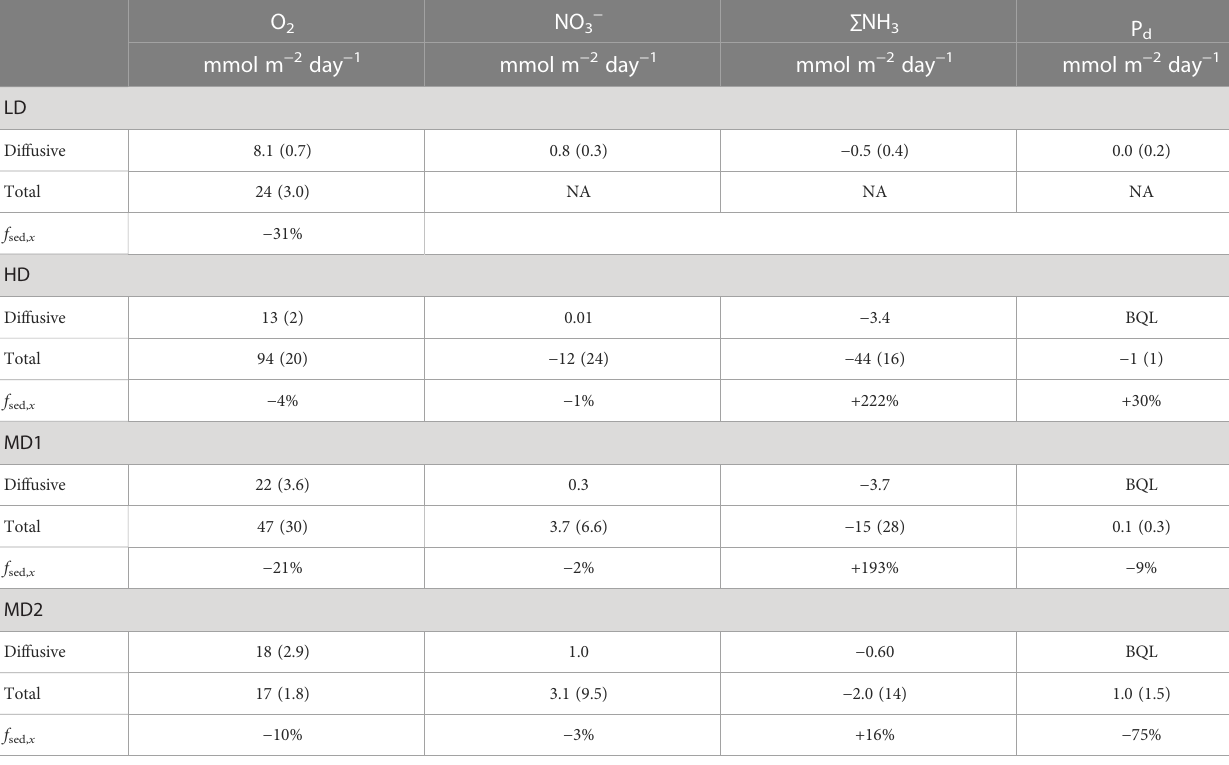
TABLE 2 Average total and diffusive fl uxes of O 2 , NO 3 − , ∑ NH 3 , and P d at the sediment – water